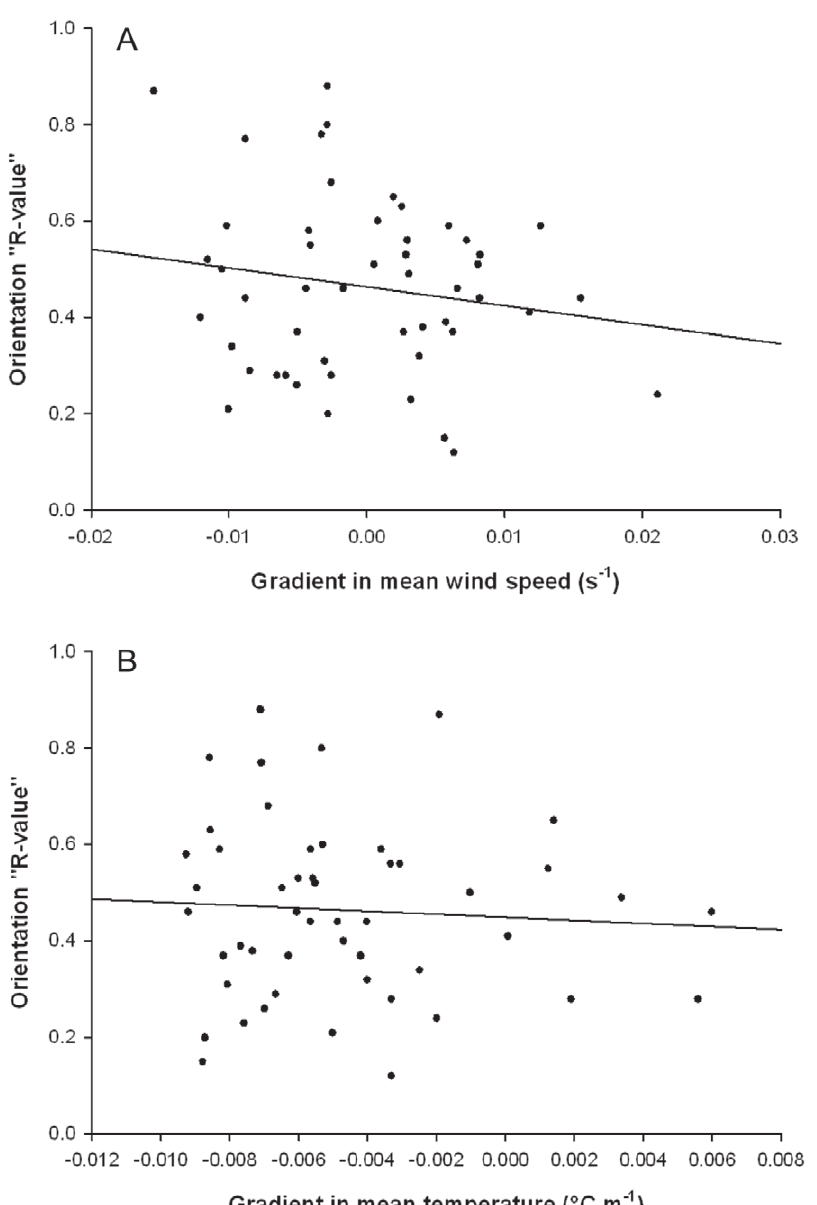
Figure 3. The ‘tightness’ of orientation direction in small insects and gradients in wind speed and temperature. Linear regression analyses for N=50 nocturnal ‘events’ of medium-sized insects ( , 80 mg). ( A ) Orientation ‘R-value’ and gradient in mean wind speed shear: df =1, 48, R 2 , 0.001, F=1.38, P=0.246. ( B ) Orientation ‘R-value’ and gradient in the mean temperature: df =1, 48, R 2 , 0.001, F=0.21, P=0.652.